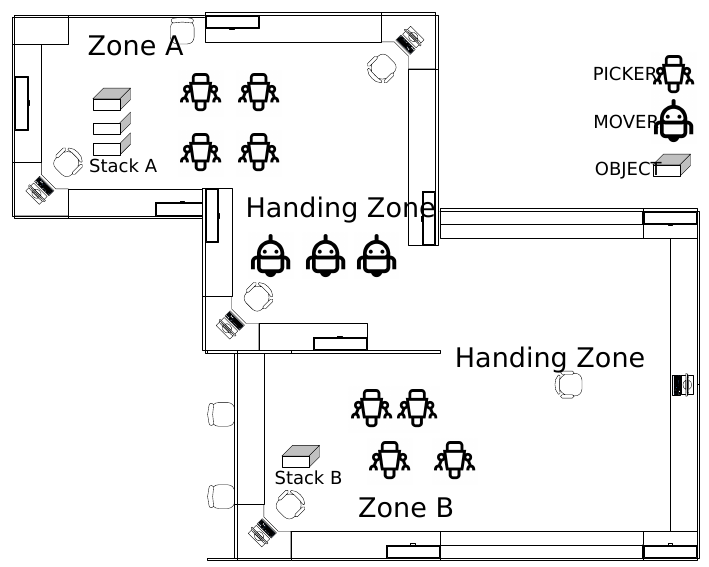
Figure 6. RPN structure of the robot automation process demonstrated in this